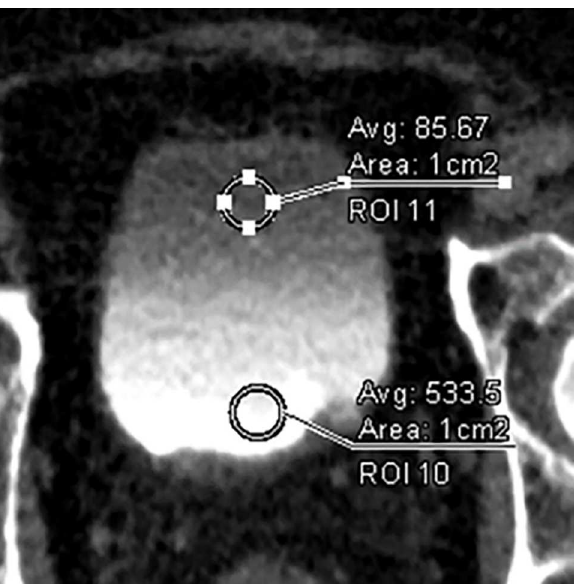
Fig 2. Axial CT images obtained in the excretoryphase with a 5-minute delay in a 67-year-old man, with ROIs manually drawn at the anterior and posterior portions of the urinary bladder. The sizes of the ROIs were kept constant on the anterior and posterior portions with a copy-and-paste